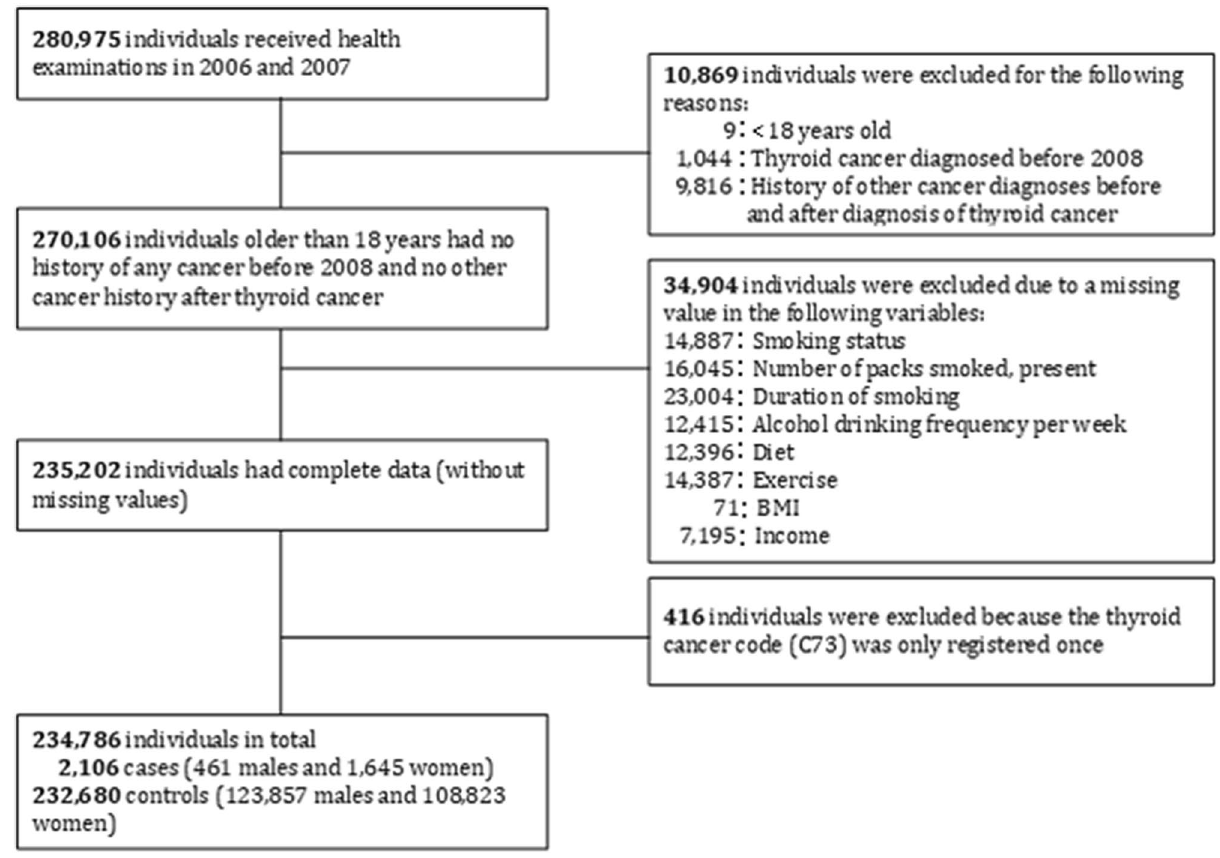
Figure 1. Data flow diagram of the cohort